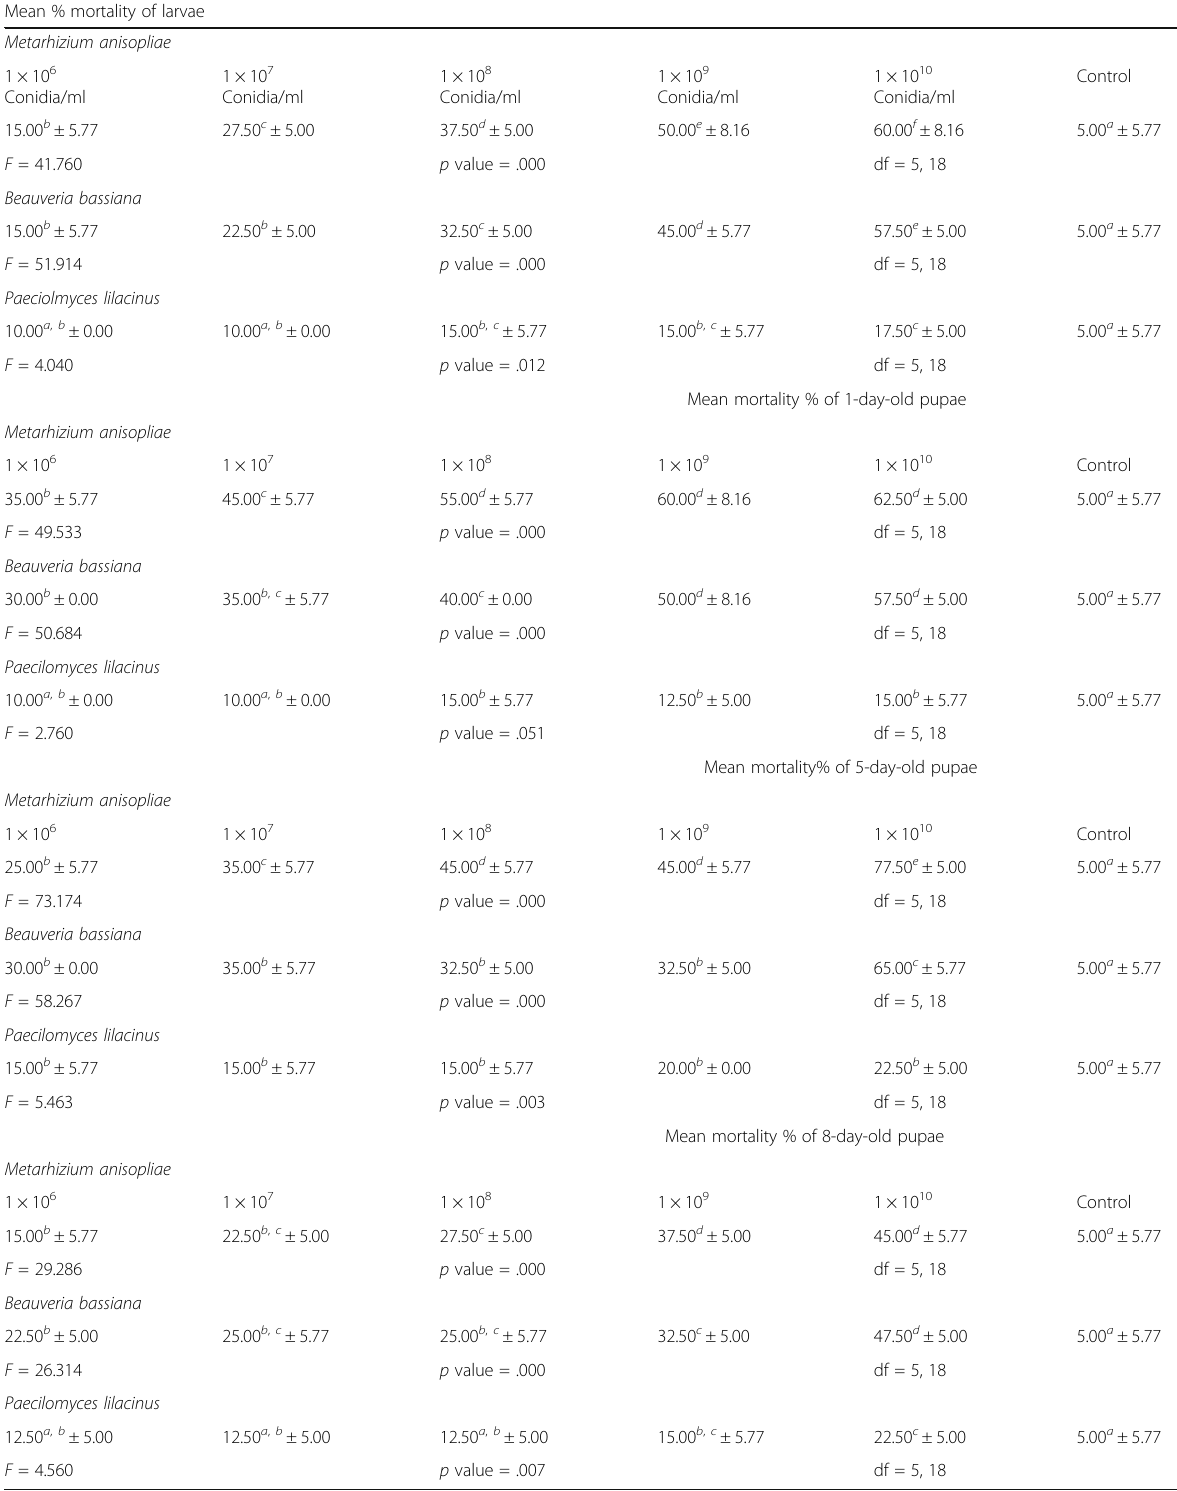
Table 1 Susceptibility of Ceratitis capitata immature stages to Metarhizium anisopliae , Beauveria bassiana , and Paecilomyces lilacinus at different